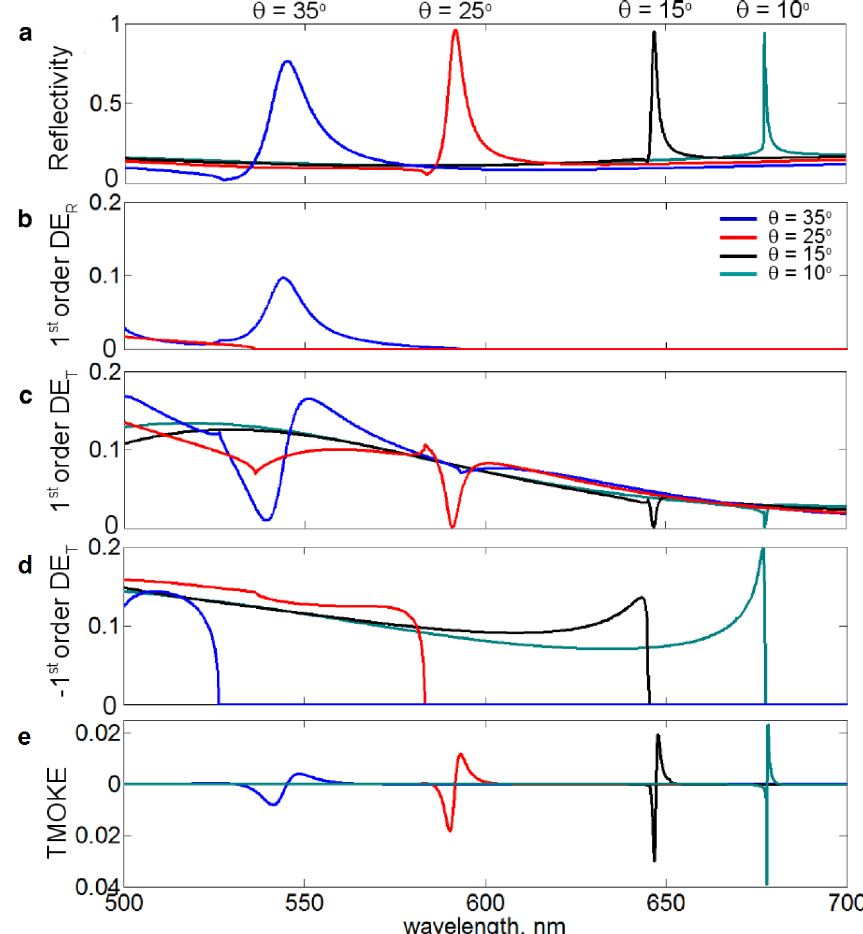
Figure 10. ( a ) Reflectivity and ( b–d ) Reflected ( DE efficiency for the +1 st and 1 st orders of the Bi:YIG-Si grating at different angles of incidence θ ; ( e ) TMOKE response of the grating at different θ . The minor secondary peaks in the spectra occur at the Rayleigh wavelengths. Reproduced with permission from